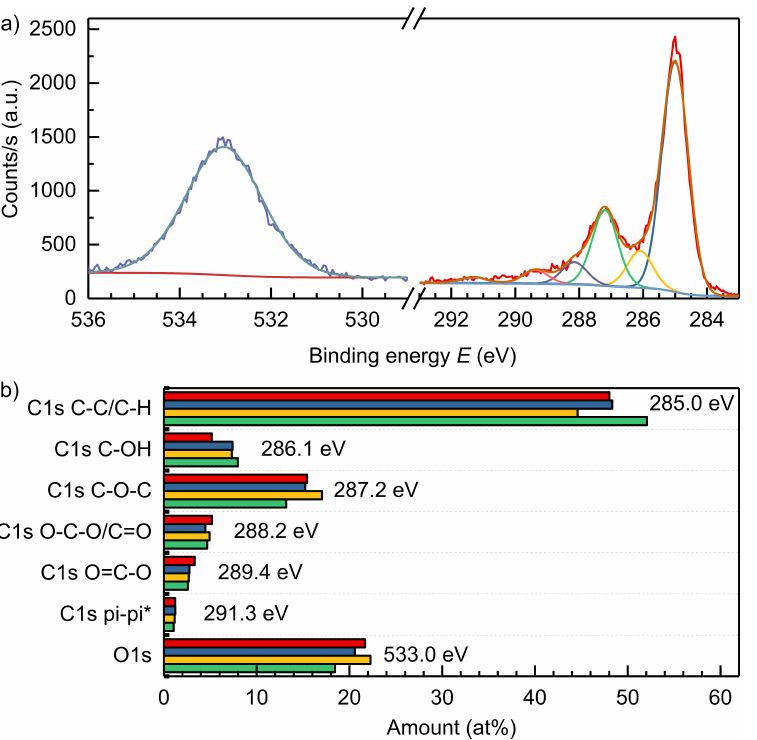
Figure 3. ( a ) XPS spectra of the GO powder produced in a 1600 mL reactor (Batch I) with the deconvolution of the C1s peak (raw data (red), C-C/C-H (blue), C-OH (yellow), C-O-C (green), O-C- O/C=O (violet), O=C-O (grey), pi-pi* (salmon)) and O1s peak (raw data (dark blue), fit (turquoise)); ( b ) deconvoluted XPS data showing the amount of functional groups in electrochemically produced graphene oxide powders in a 500 mL reactor (red) and three different batches produced in a 1600 mL reactor (Batch I blue, Batch II yellow, Batch III green). Table 3. Powder conductivity σ measured for the graphite educt, graphene oxide powders of different batches in the up-scaled 1600 mL reactor and comparable graphene oxide produced by Hummer’s method according to Xu et al.